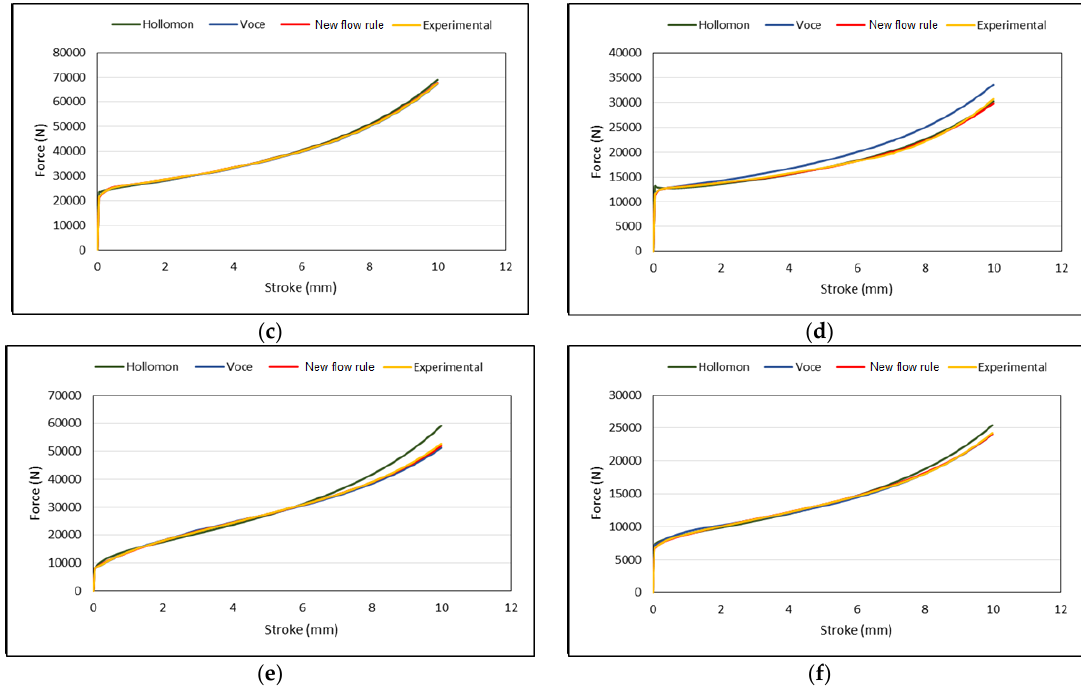
Figure 17. Load-stroke curves obtained by FEM for AA5083 at the three starting states: ( a ) AA5083 N0 25 °C; ( b ) AA5083 N0 250 °C; ( c ) AA5083 N2 25 °C; ( d ) AA5083 N2 250 °C; ( e ) AA5083 N2 + flash 25 °C; ( f ) AA5083 N2 + flash 250 °C.